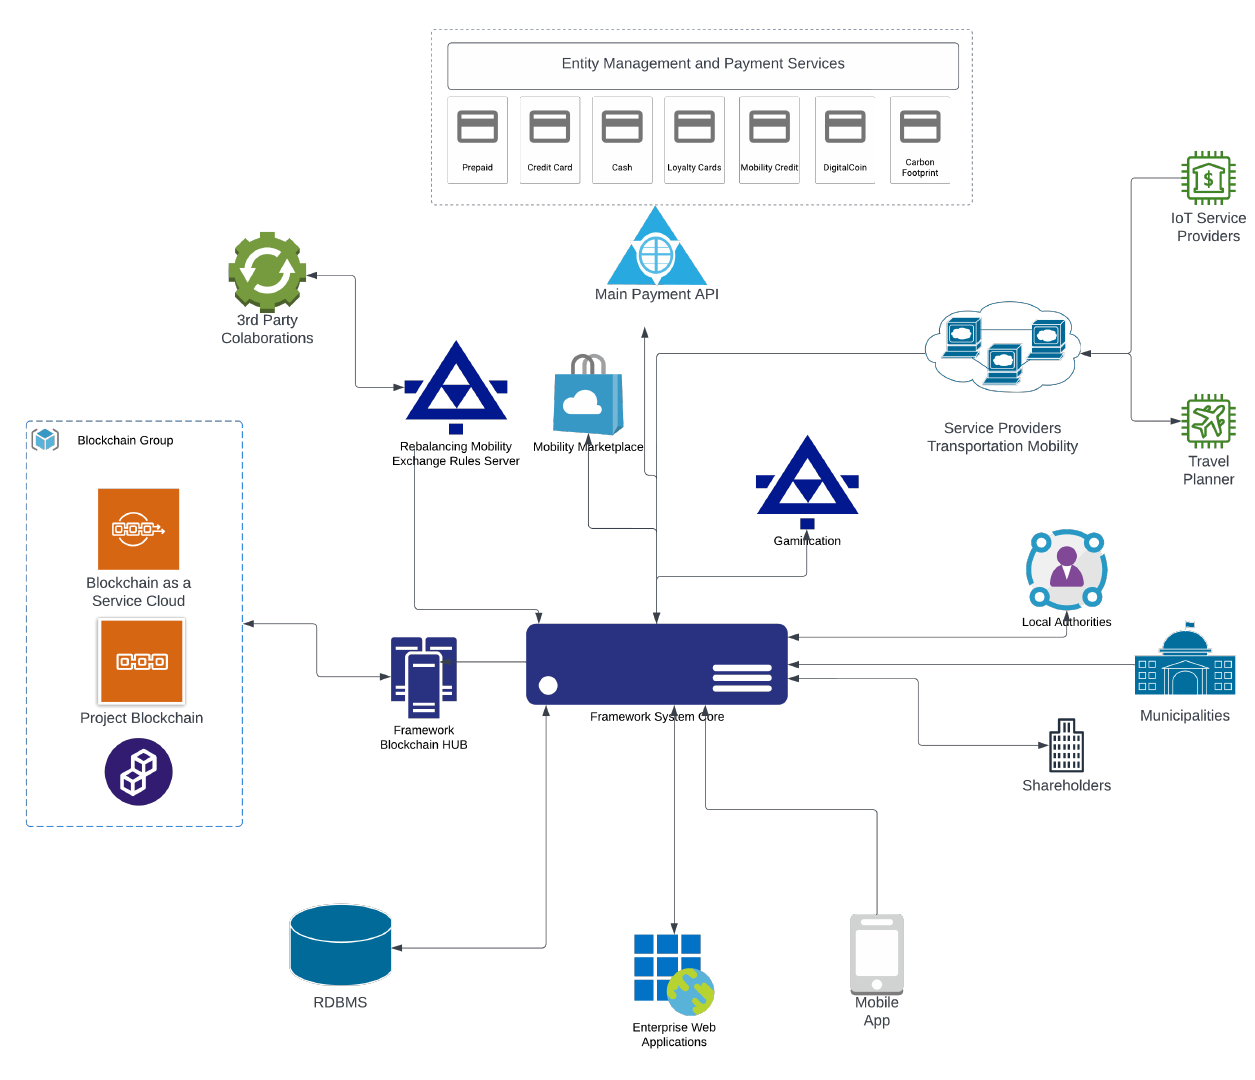
Figure 1. Framework high-level